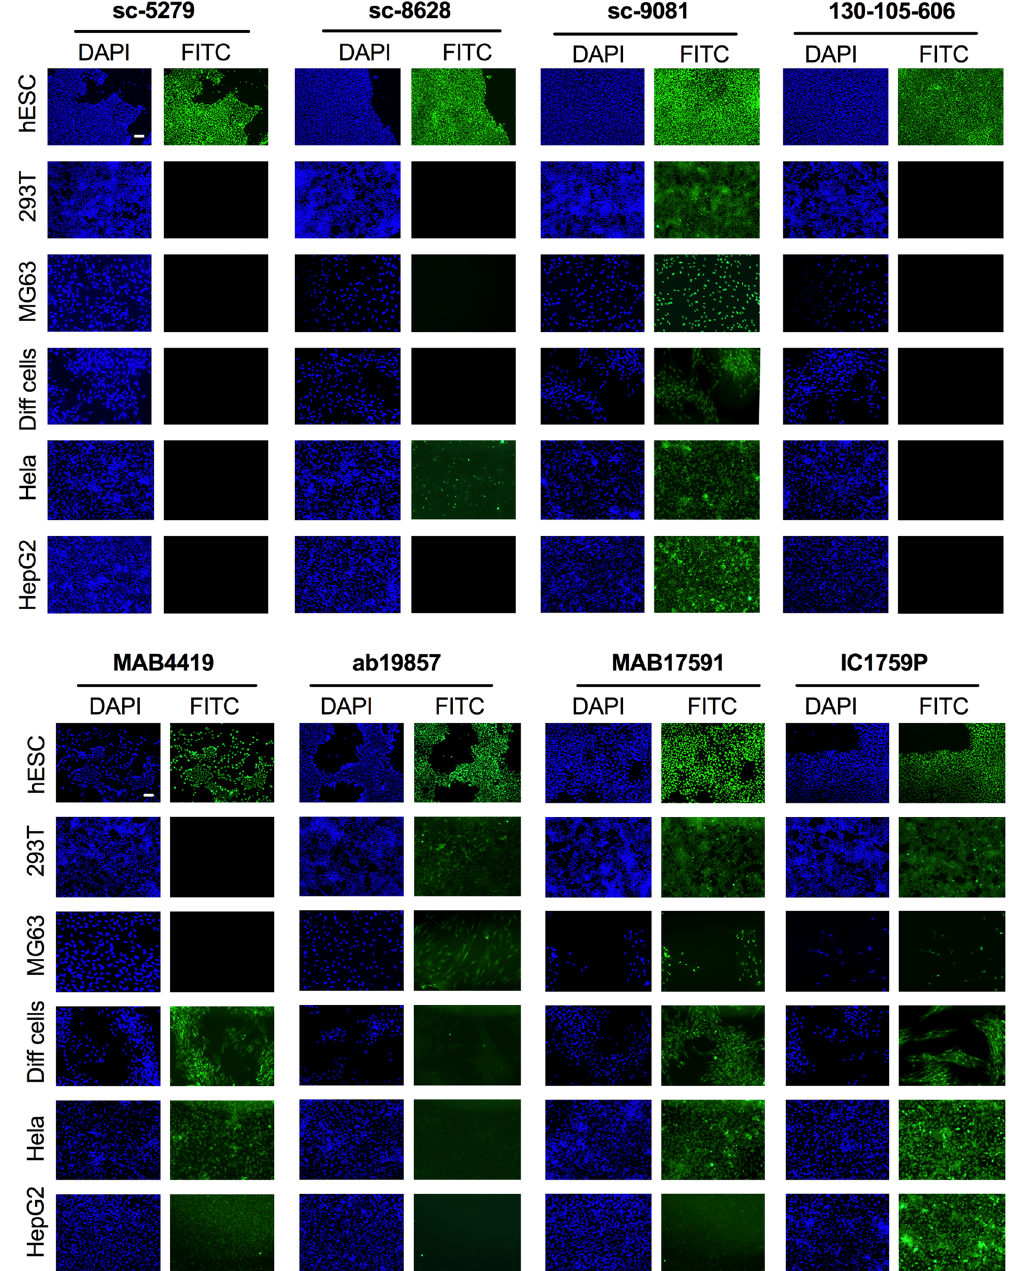
Figure 2. Specificity of various antibodies against OCT4A. Immunofluorescent cell staining showing expression of OCT4 in hESCs (positive control), MG63 (negative control), 293T, osteoblast-differentiated hAFSCs, HeLa cells and HepG2 cells. Nuclei were stained with DAPI (blue). Scale bar 50 μ